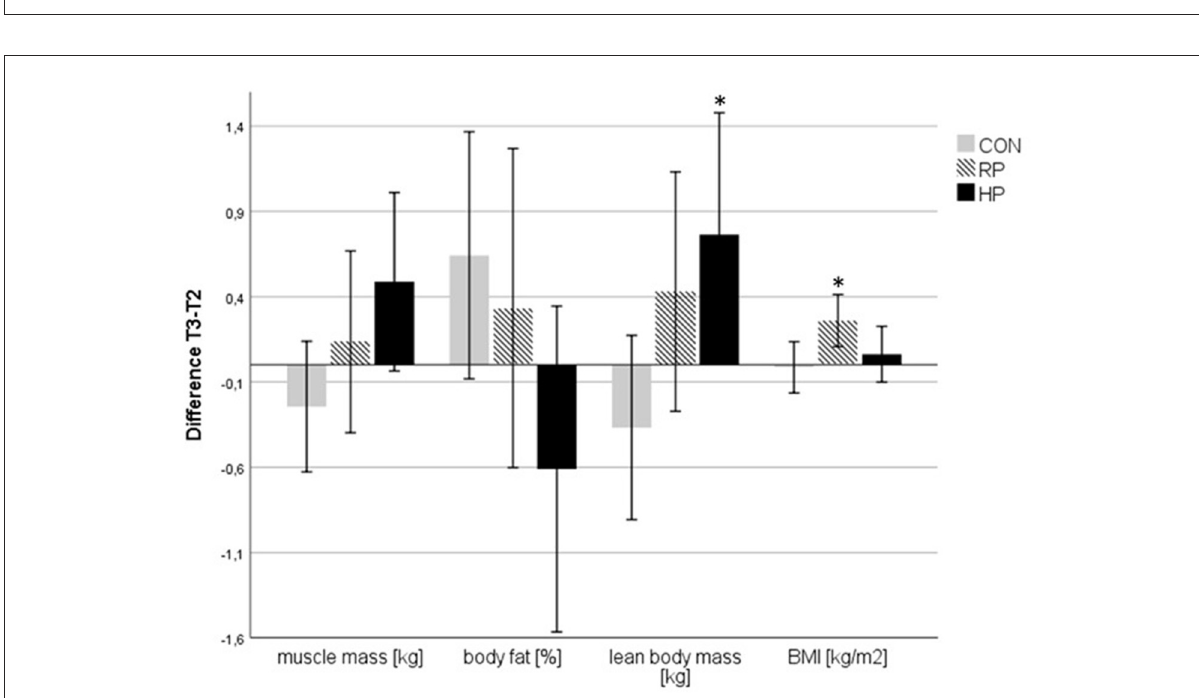
FIGURE4 Changes in body composition parameters between T2 and T3. * p < 0.05 and indicates a significant difference to CON.